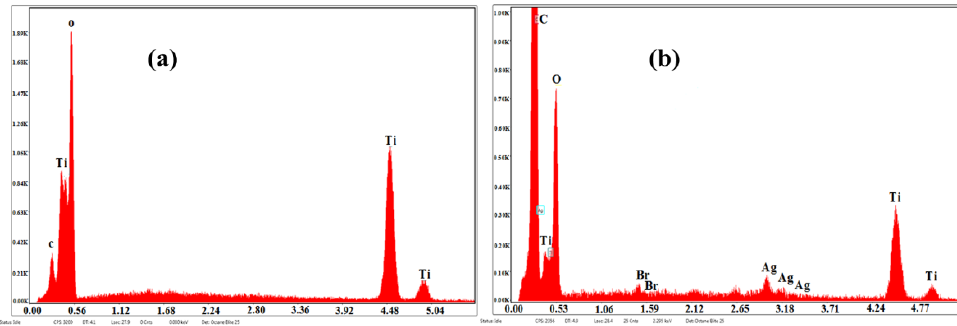
Figure 3. EDX spectra of paper–TiO 2 ( a ) and paper–TiO 2 –AgBr ( b ).